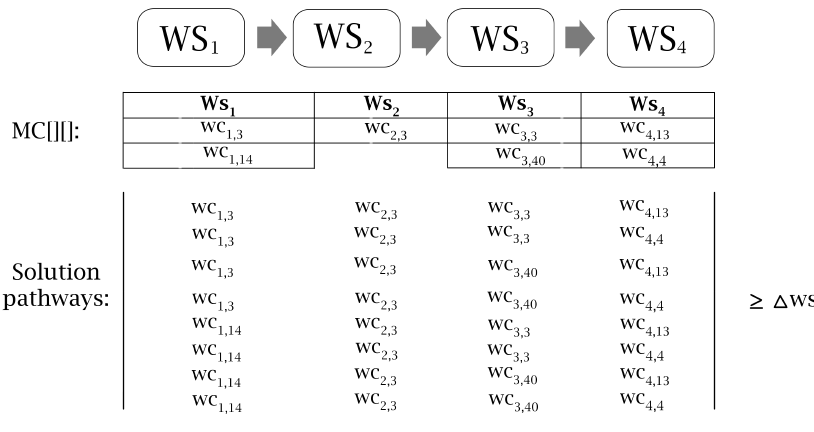
Figure 8. A WS recognition case